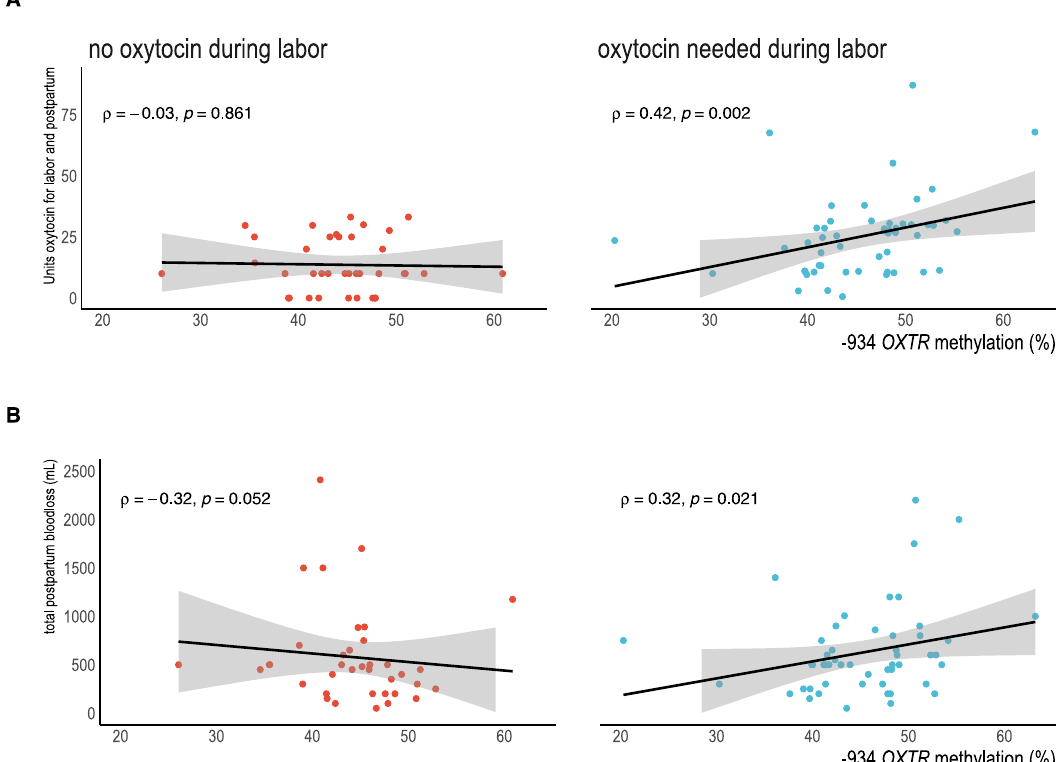
Fig. 4 Increased OXTR DNA methylation is associated with increased oxytocin use and total postpartum blood loss only when oxytocin is administered during labor. Red dots show participants without oxytocin use in labor ( n = 38); blue dots denote oxytocin was used in labor ( n = 53). Shaded area denotes 95% CI of regression line. A Higher − 934 OXTR m is associated with higher intra/postpartum administration of oxytocin among participants receiving oxytocin (blue dots). B Postpartum bleeding volume associated with DNA methylation however, severity increased when oxytocin was used in labor. Table 4 Increased severity of blood loss and greater relative risk for postpartum hemorrhage were greater when oxytocin was used in labor with higher OXTR methylation.